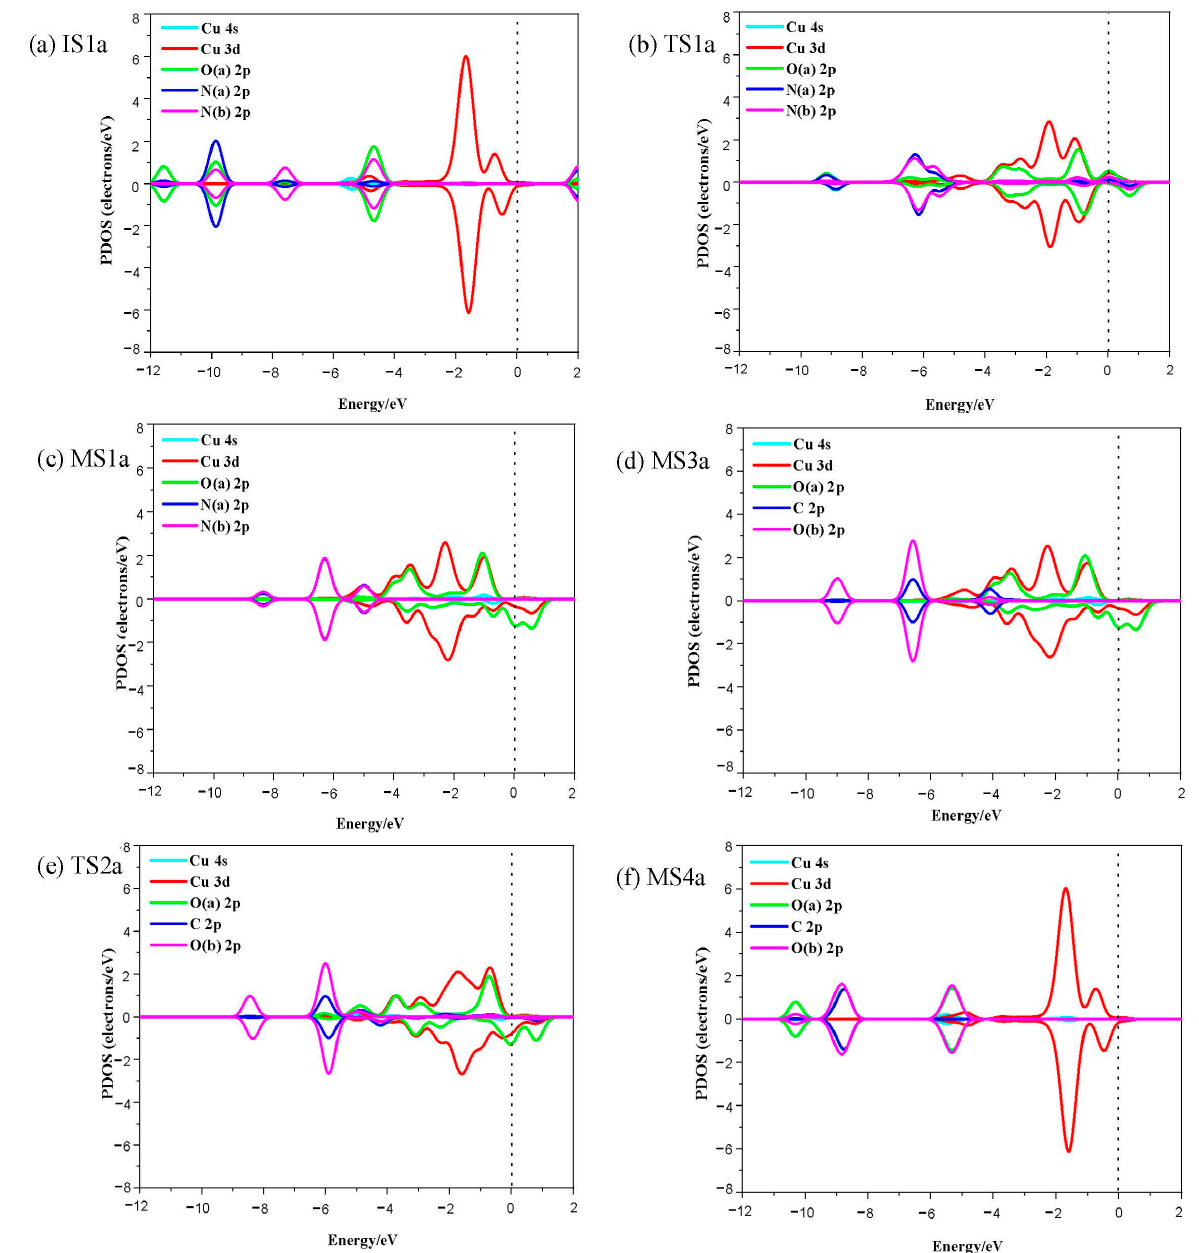
Figure 7. The PDOS of relevant species in N 2 O reduction mechanism I on Cu/C 2 N . (N(a) represents the N atom bonding with O atoms, and N(b) represents the ending N atom in N 2 O. O(a) and O(b) are from N 2 O and CO, respectively.) . ( a ) IS1a, ( b ) TS1a, ( c ) MS1a, ( d ) MS3a, ( e ) TS2a, ( f ) MS4a Table 3. The Mulliken charge of species involved in Cu/C 2 N catalytic reduction of N 2 O reaction mechanism I. (Note that N(a) represents the N atom bonding with N and O atoms, and N(b) repre- sents the ending N atom.).